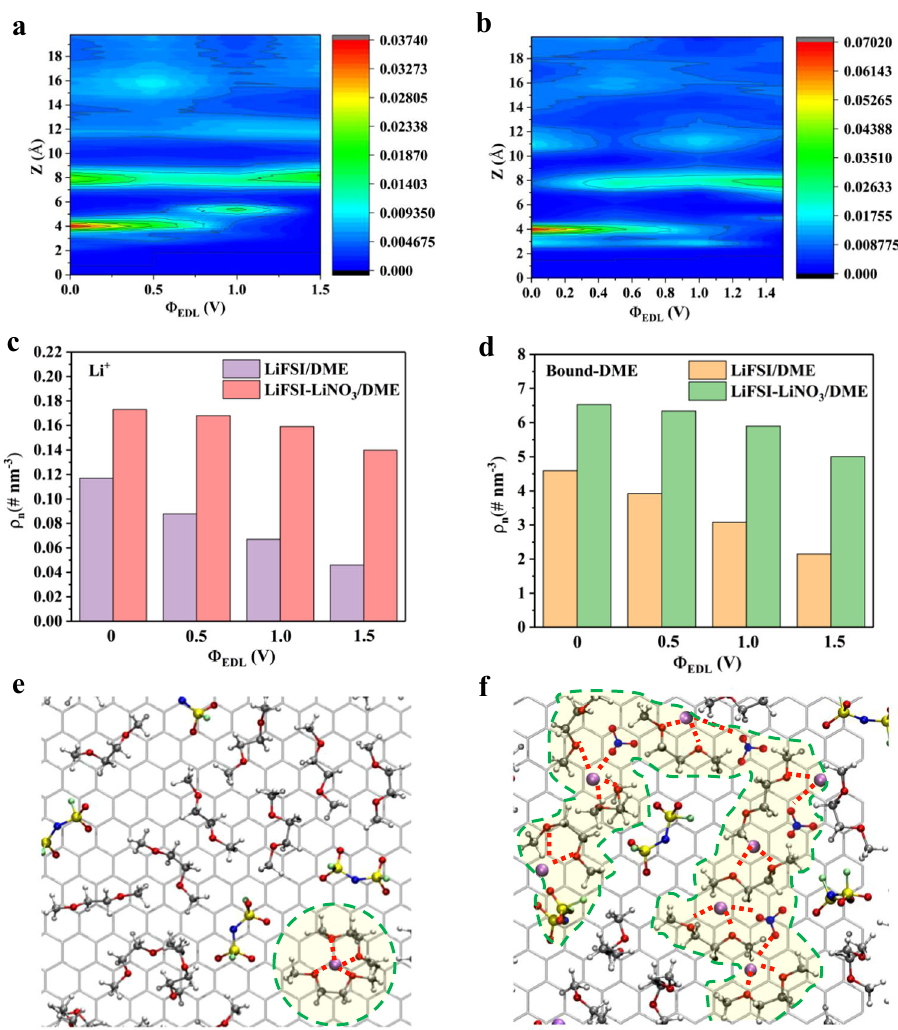
Fig. 5 Molecular dynamics simulation of EDL structure. Number densities of Li + in ( a ) 1 M LiFSI/DME and ( b ) LiFSI – LiNO 3 /DME as a function of distance from the graphite electrode (z) at various potentials ( Φ EDL). The color scale indicates the number of densities of Li + . Comparison of number densities of the ( c ) Li + and ( d ) bound DME in the interfacial region at different electrolytes system. Local structure of inner-Helmholtz interfacial regions at cathode surface in ( e ) 1 M LiFSI/DME and ( f ) LiFSI – LiNO 3 /DME at 0.5